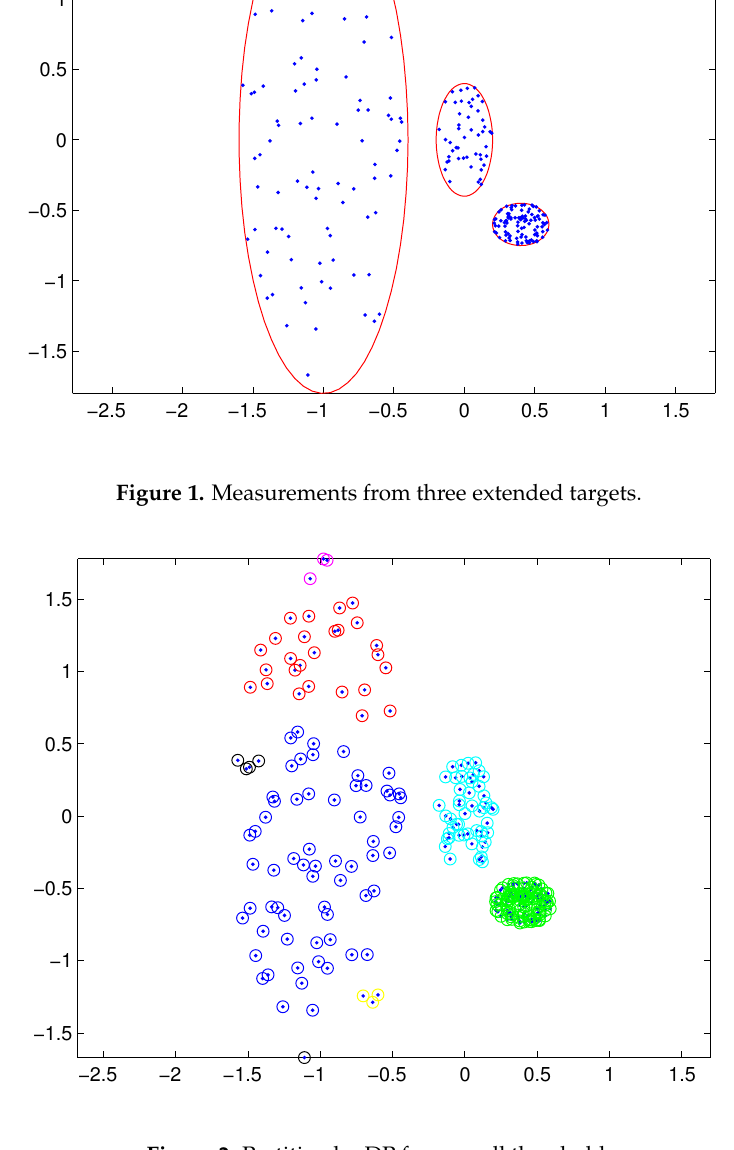
Figure 2. Partition by DP for a small